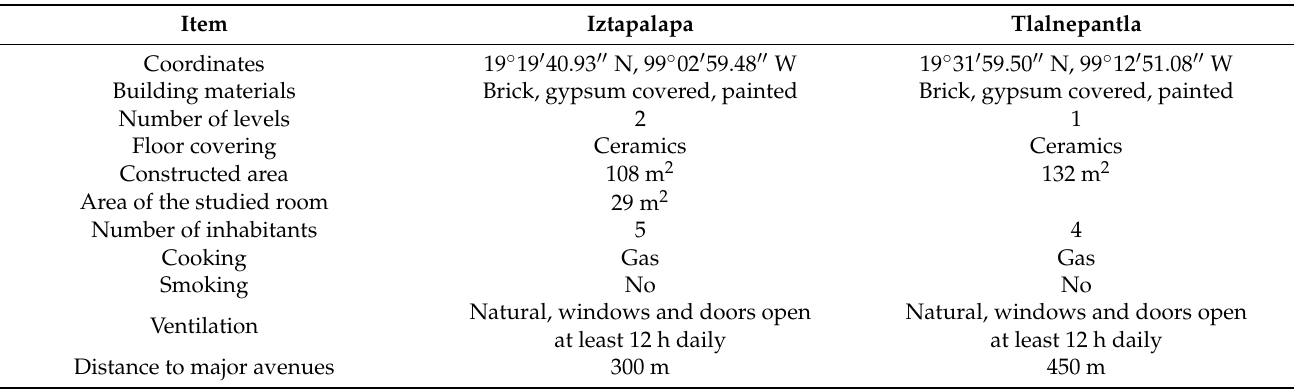
Figure 1. Map showing the location of the sites (Iztapalapa and Tlalnepantla) where the present study was conducted. The shaded region represents the urbanized surface in the Metropolitan Area of Mexico City, and the stars show where the Red Automática de Monitoreo Atmosférico (RAMA) UAM Iztapalapa and Tlalnepantla reference stations are located. Table 1. Characteristics of the sampling